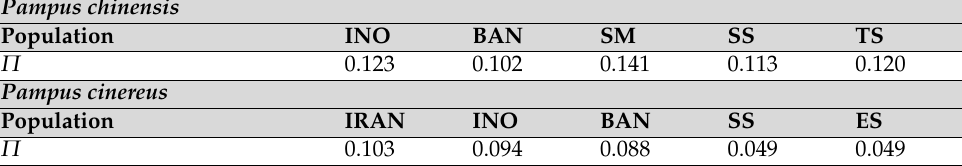
Table 2. Mean values of nucleotide diversity ( Π ) for Pampus chinensis and Pampus cinereus . INO denotes the Indian Ocean population, IRAN the Arabian Sea population, BAN the Bay of Bengal population, SM the Strait of Malacca population, SS the South China Sea population, TS the Taiwan Strait population and ES the East China Sea